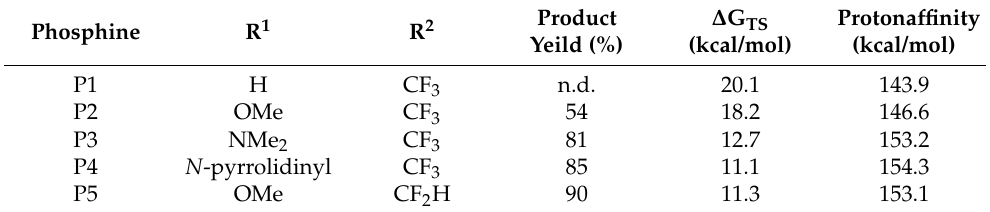
Table 4. Proton affinities of P1–P5 and free energy barriers of the nucleophilic addition reactions of these phosphines to 2 ‐ Ph ‐ pyridine.